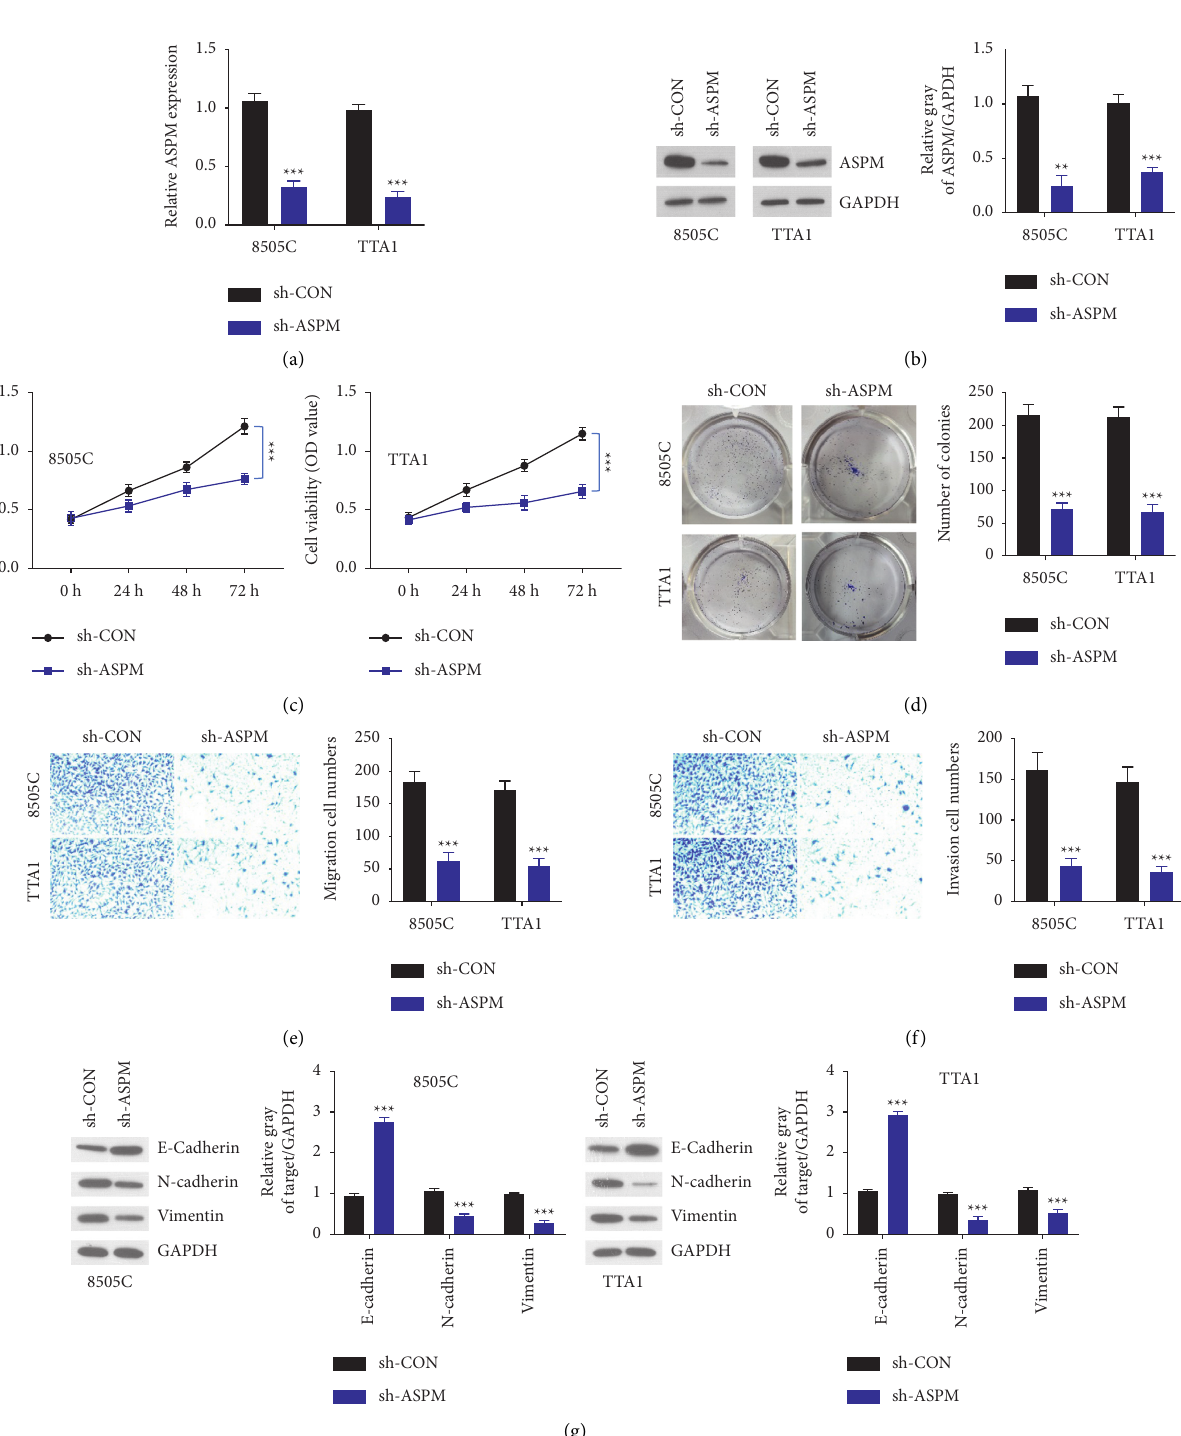
Figure 2: ASPM depletion inhibits proliferation, migration, and invasion of ATC cells. ((a), (b)) Validation of ASPM knockdown in 8505C and TTA1 cells by qRT-PCR and western blotting. ((c), (d)) ATC cell proliferation was evaluated by CCK-8 assay and colony formation assay. ((e), (f)) Migration and invasion abilities of ATC cells were assessed by Transwell assay. (g) The protein levels of E-cadherin,